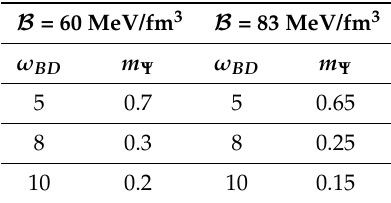
Table 3. Critical values of m Ψ for different values of B and ω BD corresponding to PSR J1614-2230 ( M = 1.97 ± 0.04 M (cid:74)